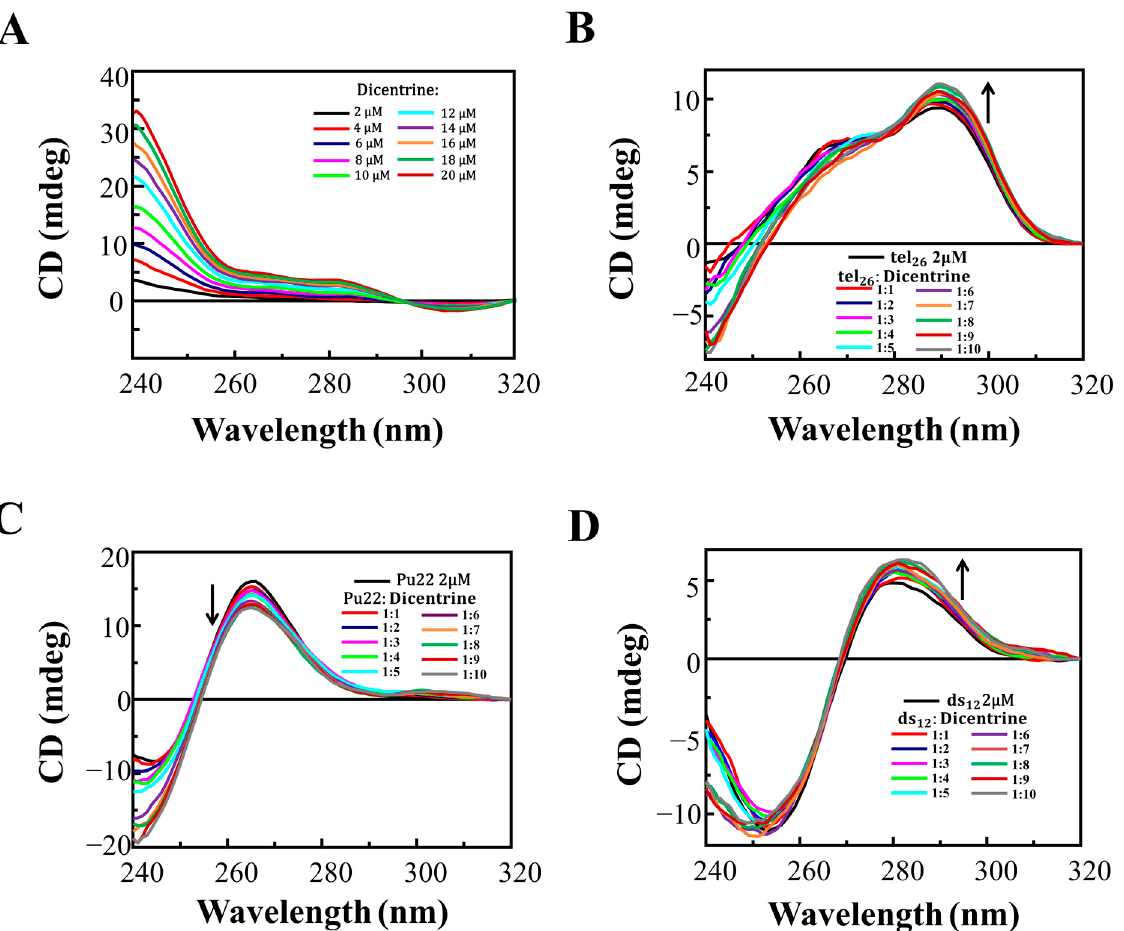
Figure 1. ( A ) CD spectra of solutions of Dicentrine (from 2 to 20 μ M) in 5 mM KCl, 5 mM KH 2 PO 4 , 5% DMSO buffer (pH 7) and CD spectra of 2 µ M solutions of ( B ) tel 26 G-quadruplex, ( C ) Pu22 G-quadruplex and ( D ) ds 12 duplex in 5 mM KCl, 5 mM KH 2 PO 4 , 5% DMSO buffer (pH 7) in the presence of increasing amounts of Dicentrine (up to 10 equivalents). Arrows indicate the CD changes on increasing the ligand concentration.